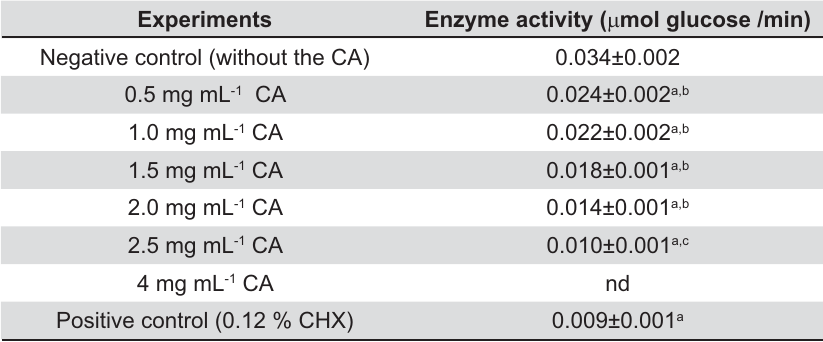
Scanning Electron Microscopic study of Piper betle L. leaves extract effect against Streptococcus mutans ATCC Table 3- The effect of crude aqueous Piper betle (cid:6)#(cid:29)(cid:6)(cid:9)(cid:23)(cid:7)(cid:17)(cid:11)(cid:18)(cid:7)(cid:6)(cid:19)$&(cid:22)(cid:6)(cid:20)(cid:5)(cid:6)(cid:7)(cid:8)(cid:9)(cid:6)(cid:11)(cid:18)(cid:7)(cid:3)(cid:4)(cid:3)(cid:7)(cid:15)(cid:6)(cid:20)(cid:14)(cid:6)(cid:16)(cid:11)(cid:17)(cid:7)(cid:3)(cid:11)(cid:31)(cid:31)(cid:15)(cid:6)(cid:16)(cid:13)(cid:17)(cid:3)(cid:28)(cid:9)(cid:24)(cid:6)$&’(cid:6)(cid:19)*(cid:11)!(cid:9)(cid:24)(cid:6)(cid:20)(cid:5)(cid:6)(cid:7)(cid:8)(cid:9)(cid:6)(cid:17)(cid:11)(cid:7)(cid:9)(cid:6) of production of water insoluble glucan, determined from the glucose content). Results are expressed as the mean value ± standard deviation of 9 determinations. CHX - chlorhexidine. (Statistic analysis: one-way ANOVA)